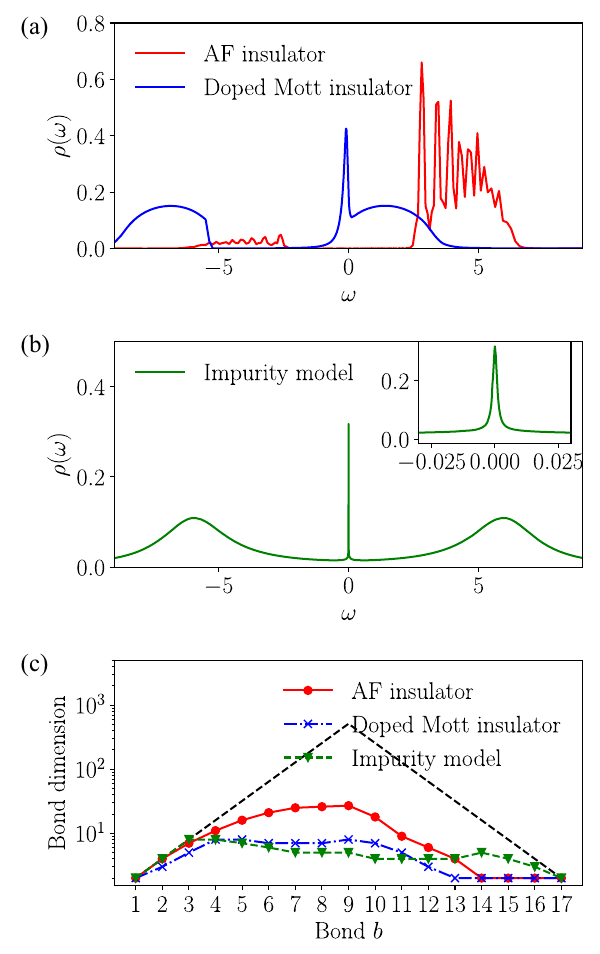
FIG. 13. Compression of the real-frequency spectral functions of an AF insulator, a doped Mott insulator, and an impurity model. See the main text for a more detailed description of the models. (a) Spectral functions of the AF insulator and the doped Mott insulator, (b) spectral function of the impurity model (an enlargement of the low-frequency region is shown in the inset), (c) bond dimensions for ϵ ¼ 10 − 8 and R ¼ 18 . The compression ratios are 40.3, 280.7, 318.1,